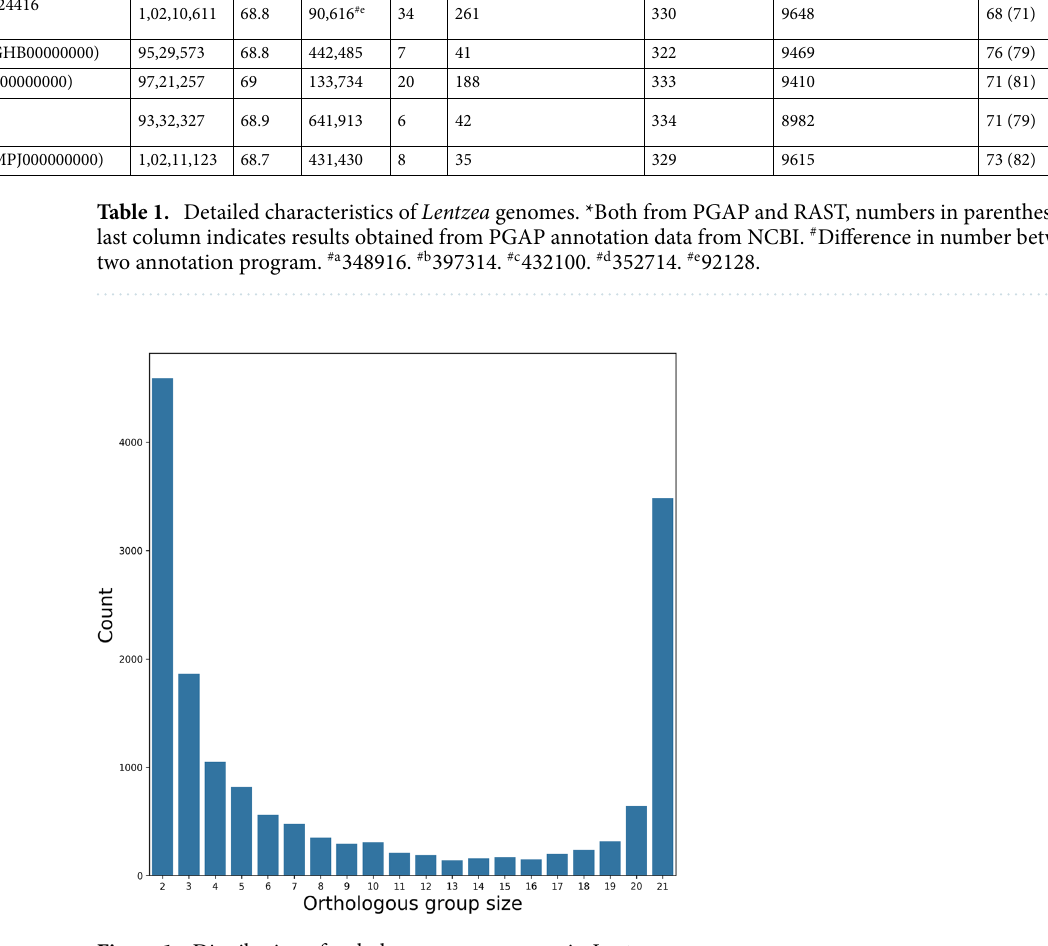
Figure 1. Distribution of orthologous genes present in Lentzea